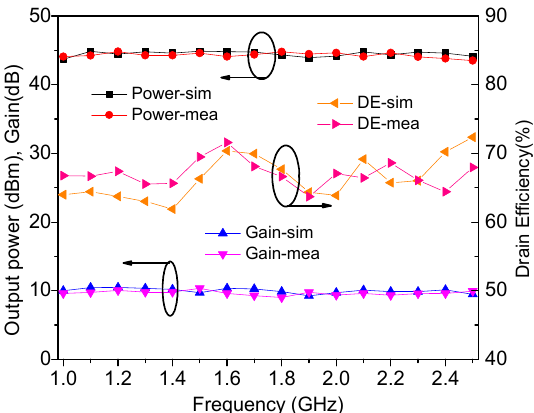
Figure 17. Measured s11, s22, and s21 of the designed DPA.